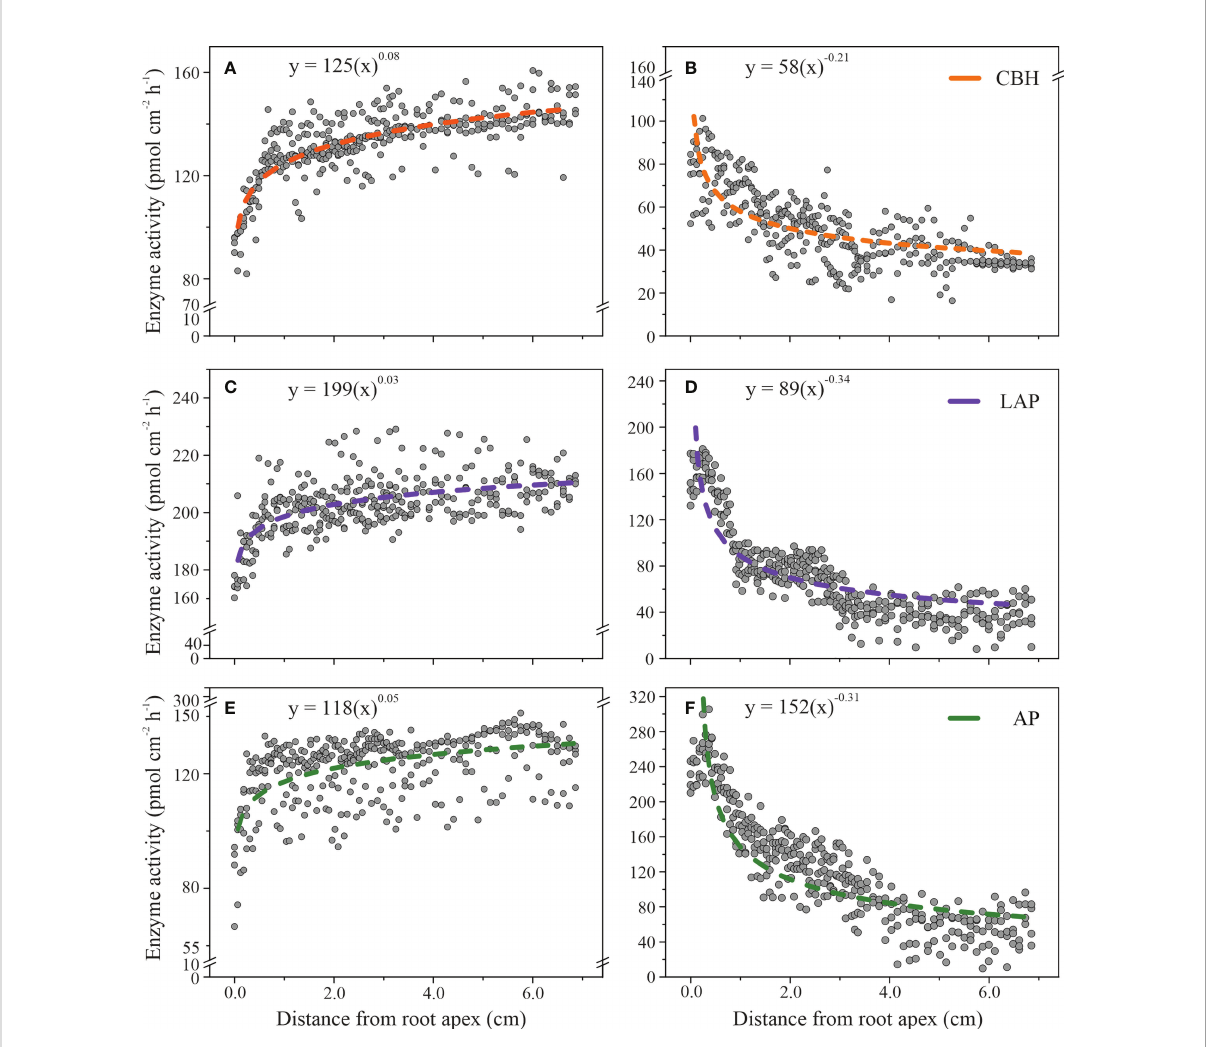
FIGURE 3 Enzyme activities on the rhizoplane as a function of the longitudinal distance from the root apex to the distal root zone in European beech (A, C, E) and Norway spruce (B, D, F) : cellobiohydrolase (CBH), leucine-aminopeptidase (LAP), and acid phosphomonoesterase (AP). The models include data from 85 individual measuring points per plant. (N =